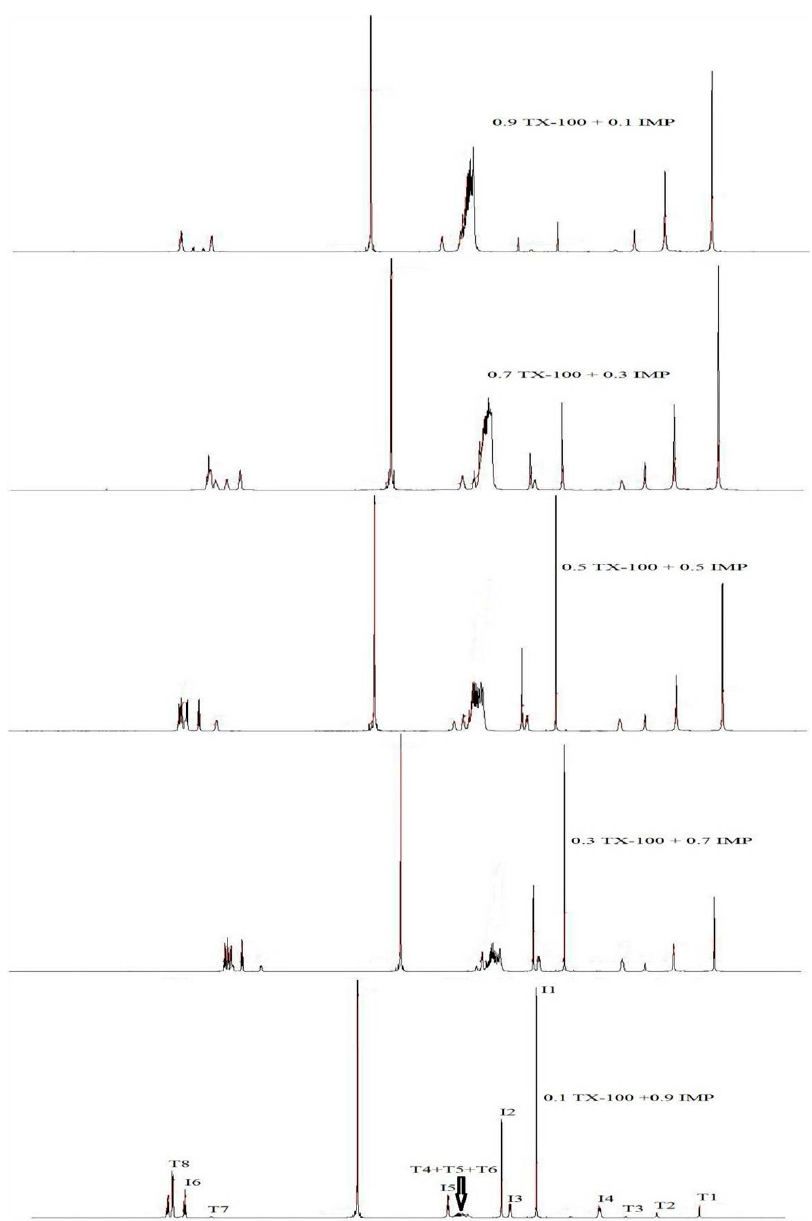
Figure 4. 1 H NMR (600 MHz) spectrum of IMP+TX-100 mixture having various α 1 of TX-100 in D 2 O. Table 4. 1 H NMR chemical shifts ( δ , ppm) of IMP+TX-100 mixtures in aqueous system.